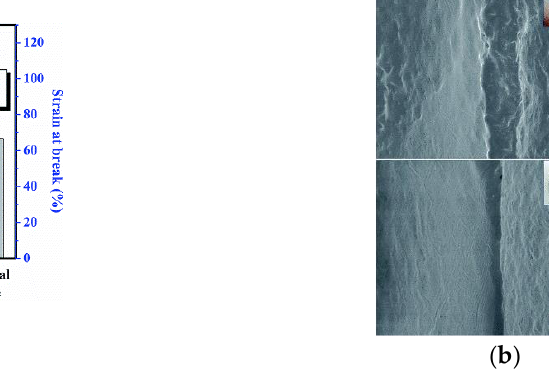
Figure 20. ( a ) Stress-strain curves for pristine and healed POSS-U/PCL-A samples; ( b ) Comparison of SEM micrographs of POSS-U/PCL-A films after 2 h (top photo) and 24 h (bottom) healing periods at room temperature (inserts—photographs of the mended samples). Reproduced from RSC Adv